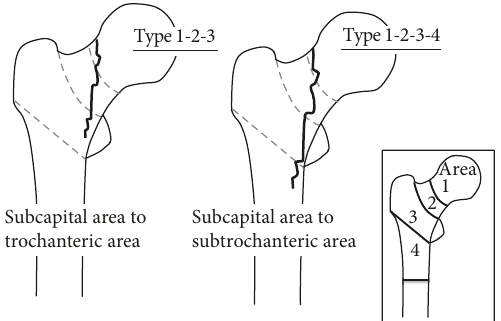
Figure 1: Type 1-2-3 fractures involving the area below the femoral head (area classification: Area 1) to the trochanteric area (Area 3) and Type 1-2-3-4 fractures involving Area 1 to the subtrochanteric area (Area 4).